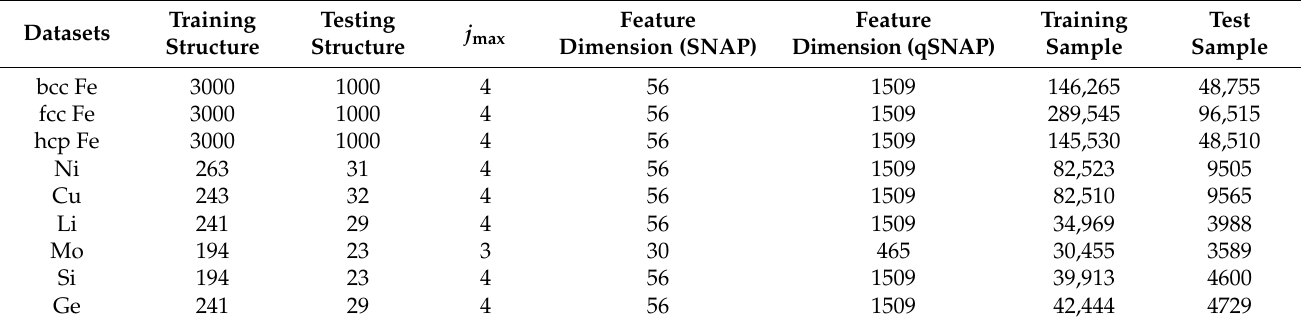
Table 1. Dataset Information.